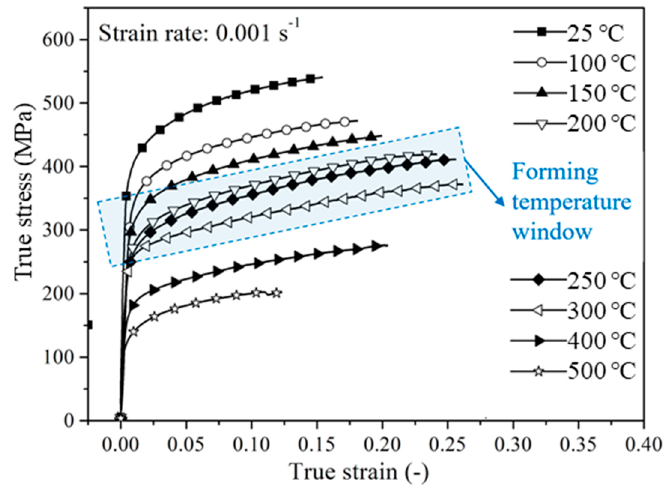
Figure 3. True stress-strain curves of CP-Ti tube at various temperatures. Table 1. Mechanical properties of CP-Ti tube at various temperatures. Fundamental Material